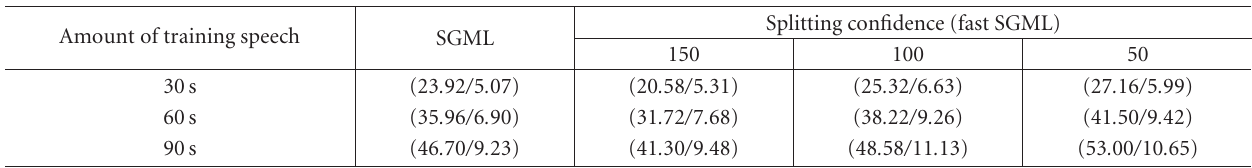
Table 1: The mean and standard deviation of the component number of the diagonal covariance male speaker GMMs obtained by the SGML and fast SGML on various amounts of training data. The first number in parentheses is the mean value while the second number after “/” is the standard deviation.